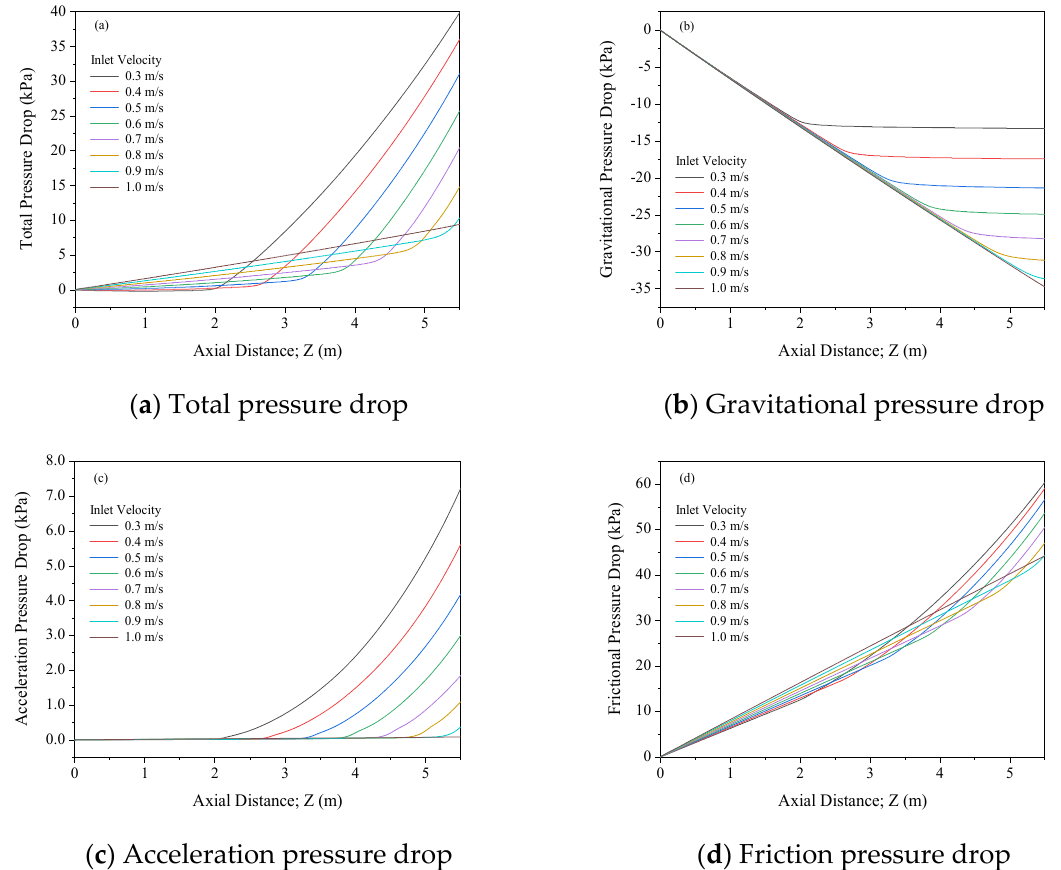
Figure 27. Distributions of the total pressure drop and its components along the axial direction at inlet velocities of 0.3 m·s − 1 to 1.0 m·s − 1. Figure 27b is the graph of the gravitational term. Since the fluid flows vertically down- ward, the gravitational pressure drop has a negative value, which means the gravitational potential energy is converted into kinetic energy. In Figure 27b, a linear decrease in the gravitational pressure drop is observed in the region before the DNB point. Additionally, in the region downstream of the DNB, the variation rate gradually falls